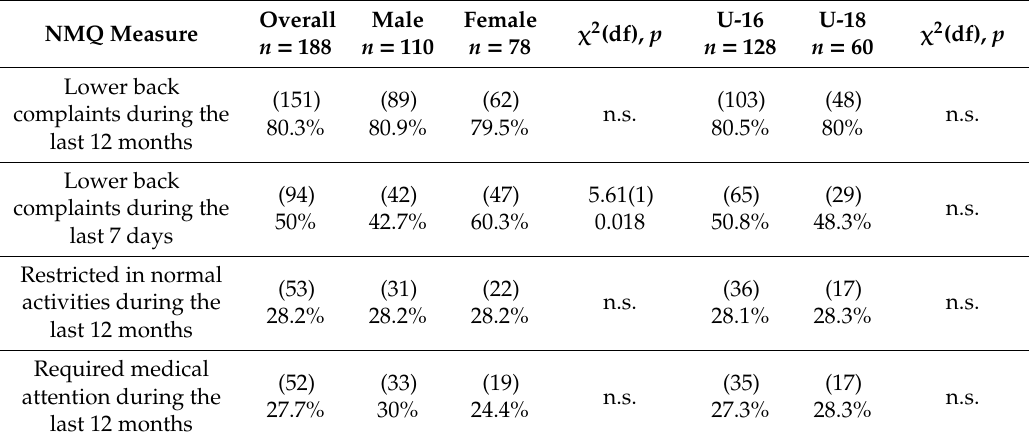
Table 1. Overview of the Nordic Musculoskeletal Questionnaire (NMQ)-based results and di ff erences between sexes and